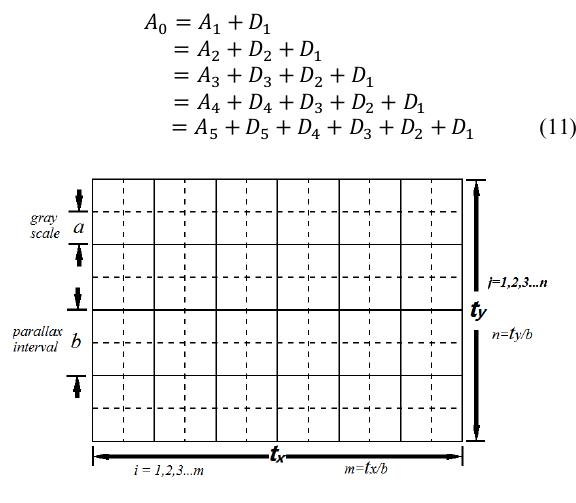
Figure 2. Parallax